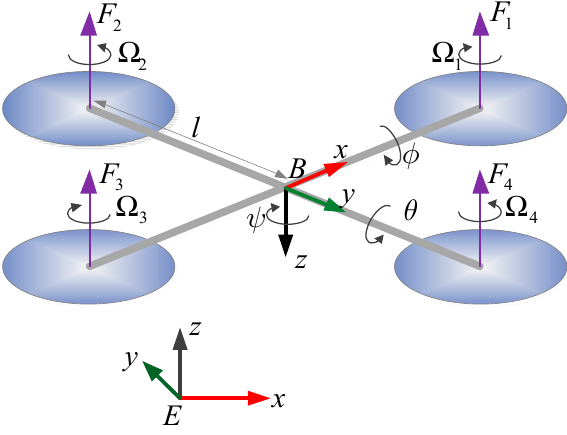
Figure 1. The quadcopter configuration.